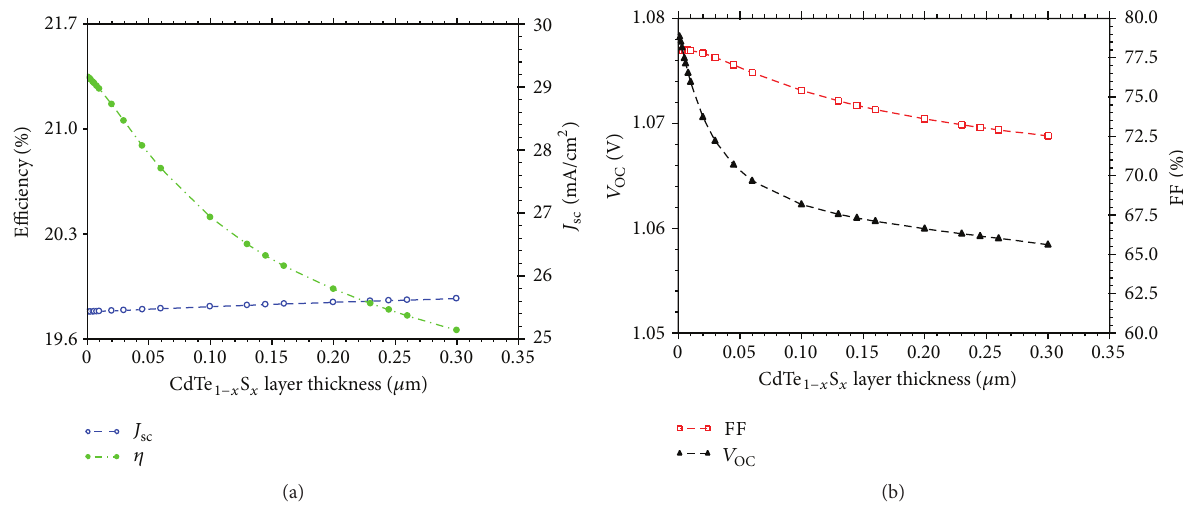
Figure 6: Effect of CdTe 1−𝑥 S 𝑥 thickness on 𝐽 sc , 𝑉 OC , FF, and efficiency of modified solar